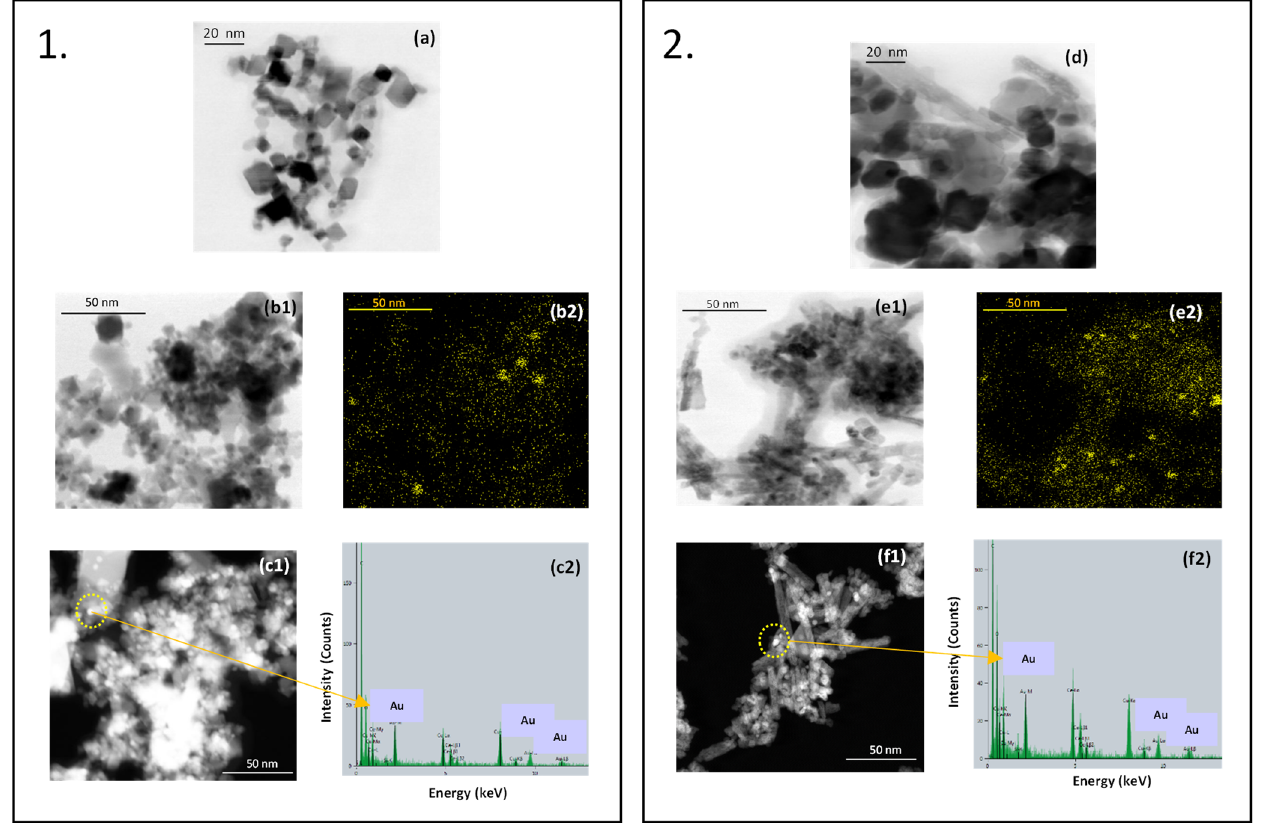
Figure 5. S/TEM-EDX analysis of Aldrich CeO 2 based samples ( Panel 1 ) and hp CeO 2 -based samples ( Panel 2 ). Bare CeO 2 A sample ( a ); 1%Au/CeO 2 A micrograph with BF detector ( b1 ) and corresponding EDXS map for Au distribution ( b2 ); 3%Au/CeO 2 A micrograph with HAADF detector ( c1 ) and corresponding EDXS spectrum of the yellow highlighted area ( c2 ). Bare CeO 2 hp sample ( d ); 1%Au/CeO 2 hp micrograph with BF detector ( e1 ) and corresponding EDXS map for Au distribution ( e2 ); 3%Au/CeO 2 hp micrograph with HAADF detector ( f1 ) and corresponding EDXS spectrum of the yellow highlighted area ( f2 ).